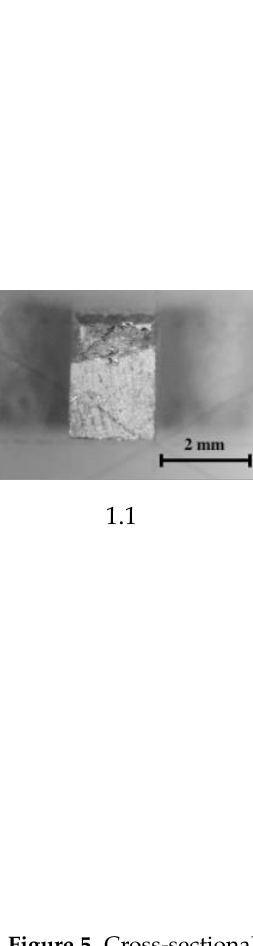
Figure 5. Cross-sectional images of the fracture of the studied samples: ( a ) initial 1550 alloy, ( b ) the image of the typical cross-section of the fracture of the welded sample after the tensile test and measurement scheme of cross section geometric parameters; 1.1, 1.2, 1.3—initial alloys with varying welding depth; a w , a n , and b —welding depth, height of non-welding area, and sample width, respectively.